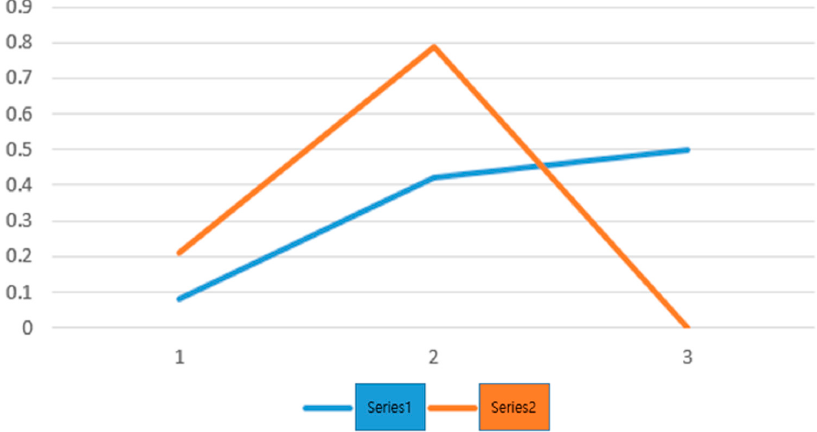
Figure 25. Comparison between the appearance frequency of “mosquito” and maximum power. (“Living Culture” section of Naver news, 2018).